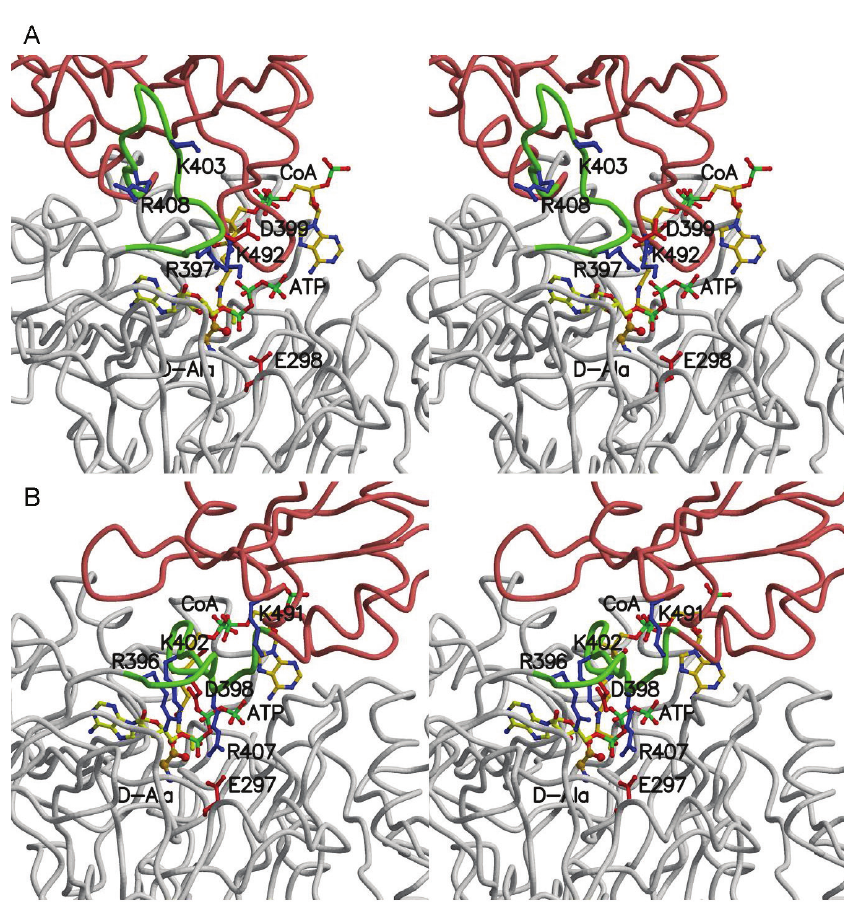
Figure 5. Structural model of DltA in complex with ATP, D-alanine and CoA. C α traces of the two modelled quadruple complexes are shown in stereo. Except for the green-colored region between Arg-397 and Glu-413, the N- and C-terminal domains are colored in gray and salmon, respectively. The three substrates and selected side-chains are shown in ball-and-stick model. A . The quadruple complex in adenylation conformation. Residue numbers in BcDltA are shown. B . The quadruple complex in thiolation conformation. Residue numbers in BsDltA are